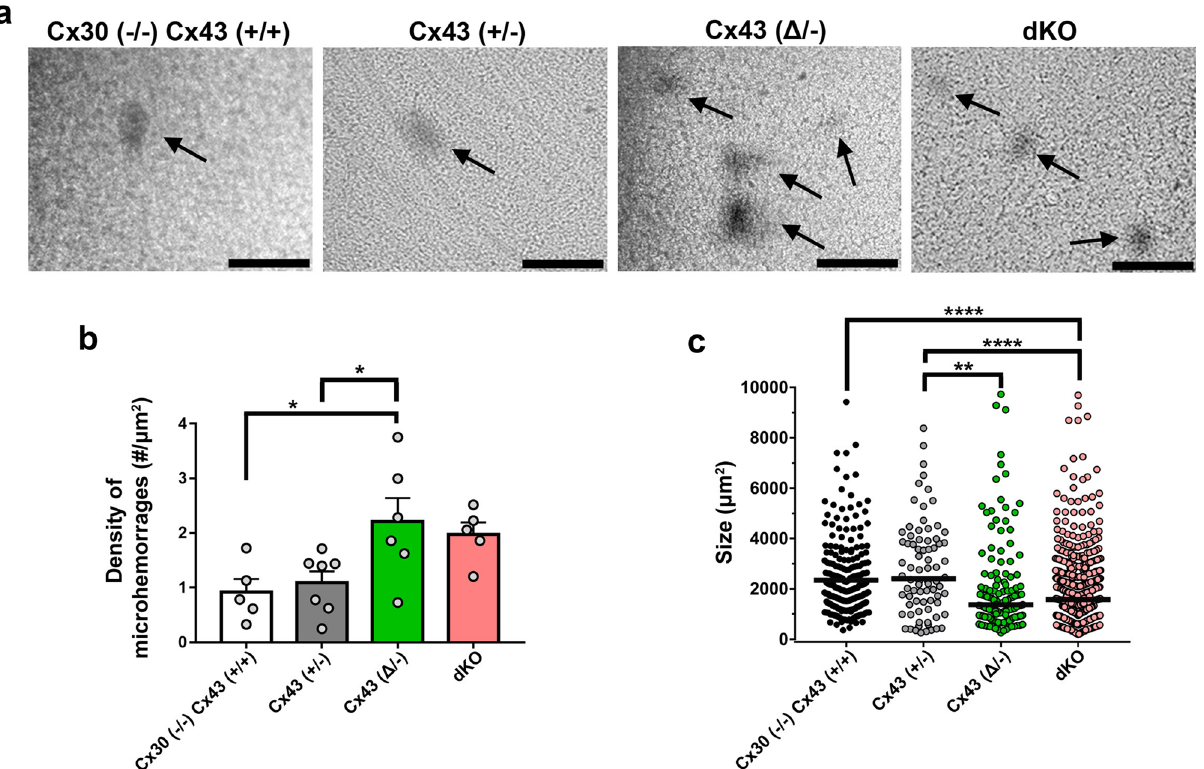
Figure 2. High pressure-induced brain leakage in Cx43 transgenic mice. ( a ) Bright-field images showing micro-hemorrhages (HRP leakage revealed with DAB in dark areas: arrows) in brains of mice as presented in Fig. 1 subjected to high hydrostatic pressure perfusion with a solution containing HRP. ( b ) Mean ± SEM values of the density of micro-hemorrhages measured in brains of mice of each genotype. ( c ) Quantification of the sizes of individual micro-hemorrhages in each genotype. Data from sections of whole hemispheres of 5 Cx43 (+/+) / Cx30 (−/−) , 6 Cx43 (+/−) , 6 Cx43 (Δ/−) and 5 dKO mice. Data are presented as mean ± SEM (ANOVA followed by Tukey’s post hoc test : * p < 0.05, ** p < 0.01, and **** p < 0.0001). Note that for panel c, the mean size values (horizontal line) were calculated per genotype and not per mouse as in panel b, because in some cases fewer than 3 microhemorrhages per mouse were present. Scale bars 100